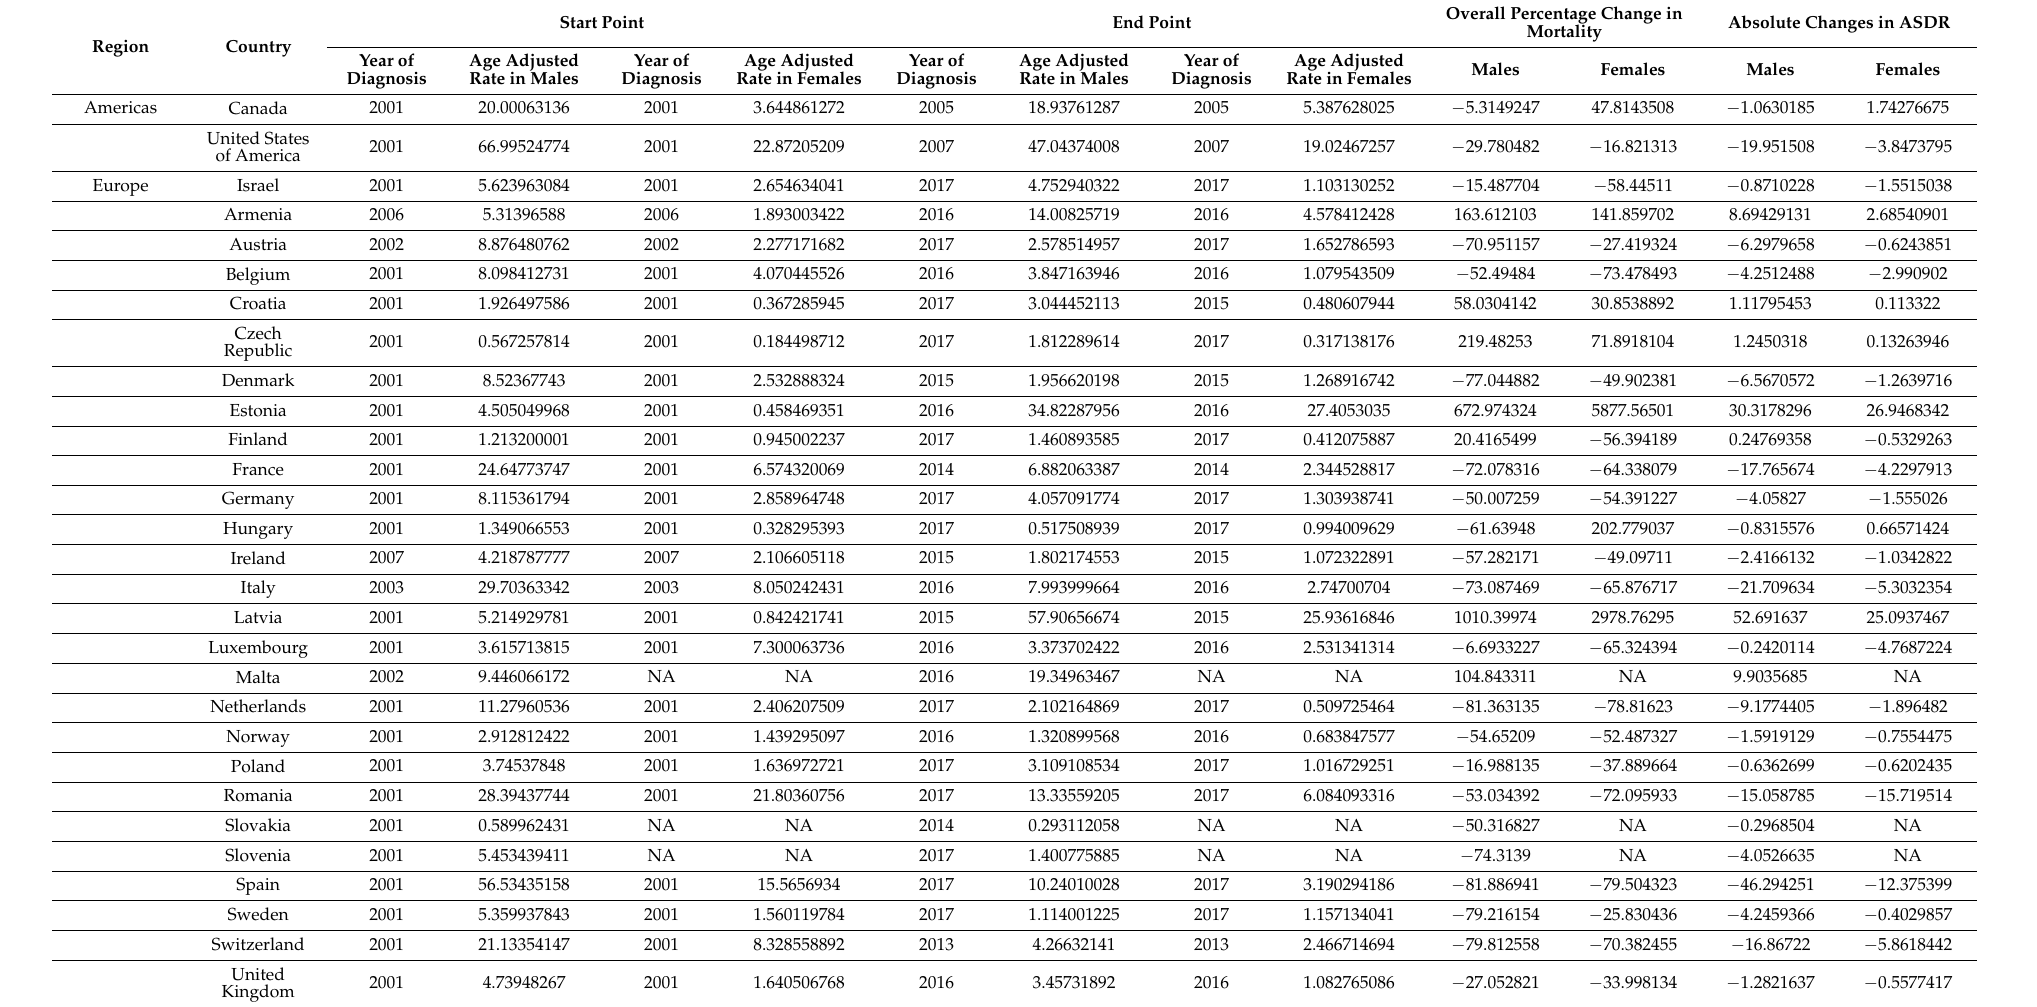
Table 1. Age-standardized death rate in males and